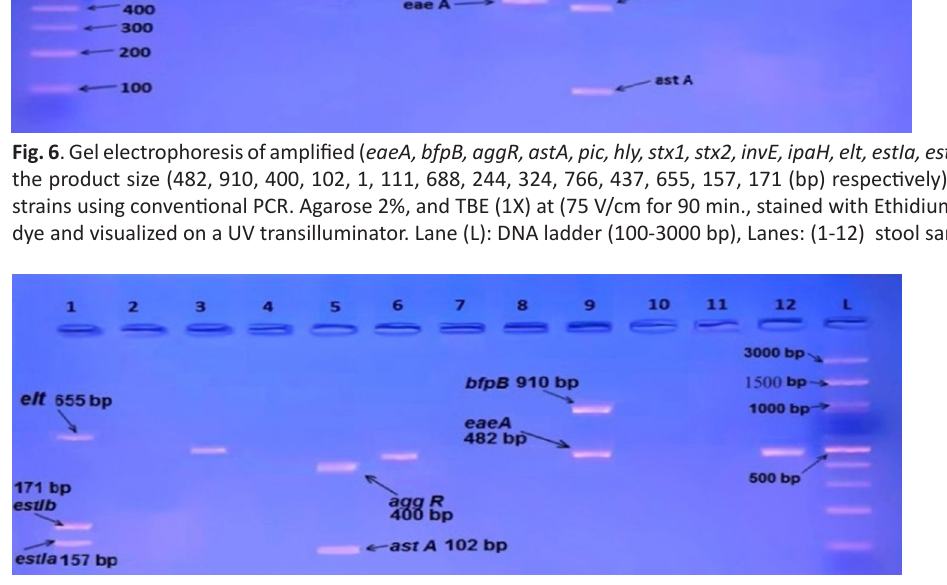
Fig. 7. Gel electrophoresis of amplified ( eaeA, bfpB, aggR, astA, pic, hly, stx1, stx2, invE, ipaH, elt, estIa ,estIb ) genes, the product size (482, 910, 400, 102, 1, 111, 688, 244, 324, 766, 437, 655, 157, 171 (bp) respectively), of E. coli strains using conventional PCR . Agarose 2%, and TBE (1X ) at (75 V/cm for 90 min., stained with Ethidium bromide dye and visualized on a UV transilluminator. Lane (L): DNA ladder (100-3000bp), Lanes: (1-12) stool samples. Enteroaggregative E.coli 17